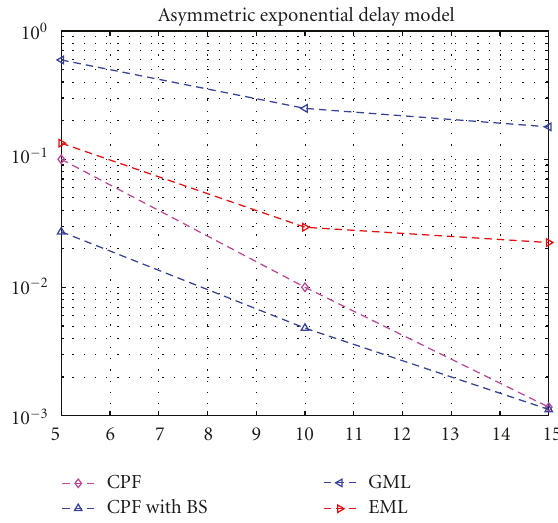
Figure 7: MSEs of clock o ff set estimators for asymmetric Exponen- tial random delay [ λ 1 = 1, λ 2 = 5] and 2 exchange message errors occur.